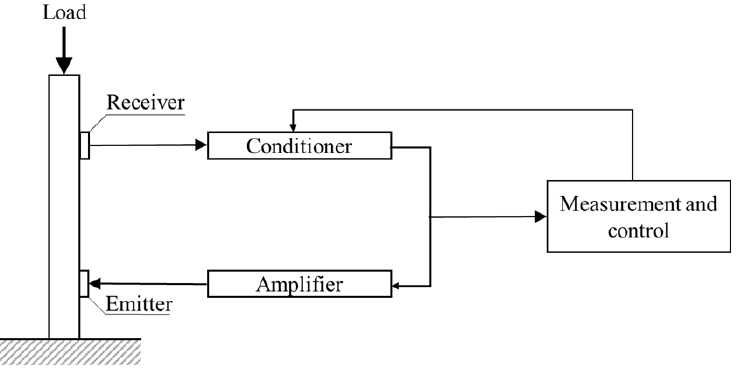
Figure 2. The SAS